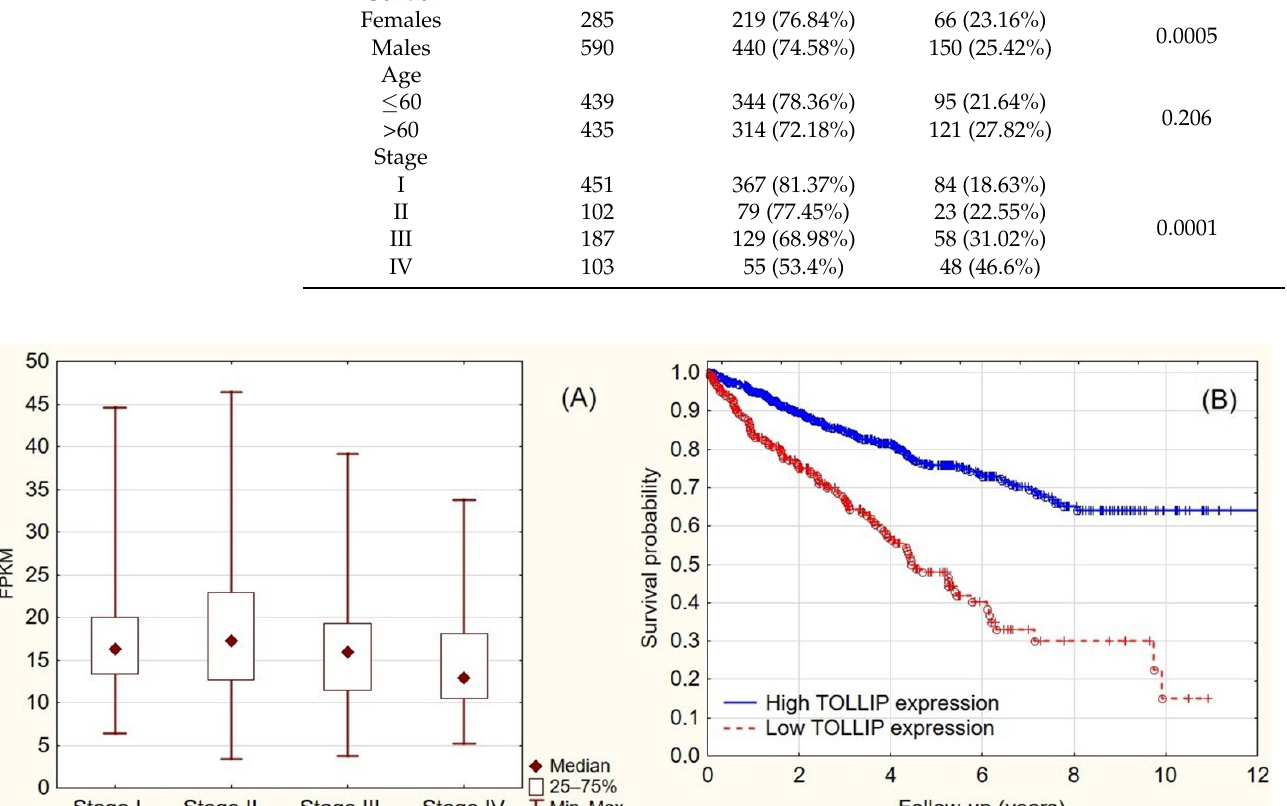
Figure 6. ( A ) TOLLIP expression in the TCGA RCC cohort depends on stage; ( B ) survival differences in the TCGA RCC groups depend on TOLLIP expression.